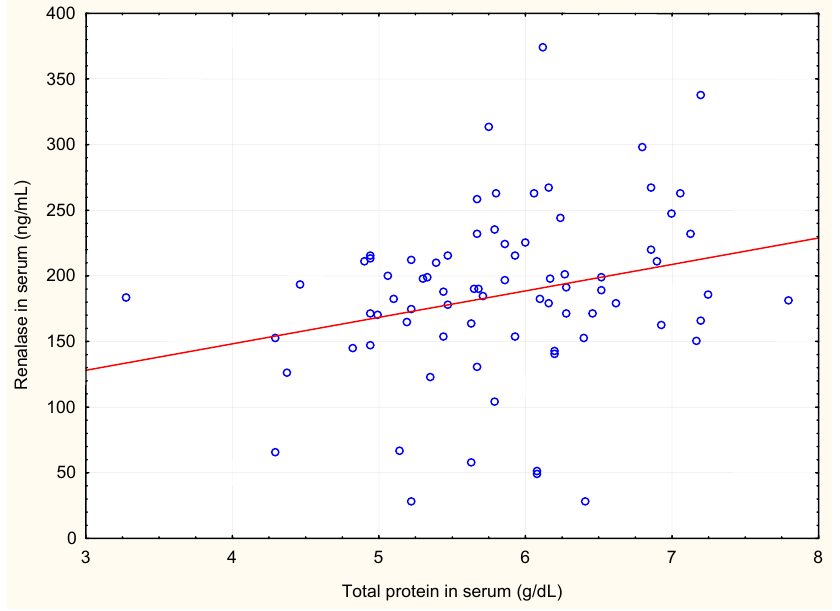
Figure 2. Correlation between concentrations of renalase per Hb (ng of renalase/1 g haemoglobin in lysates) and dopamine in plasma of hemodialysis patients.